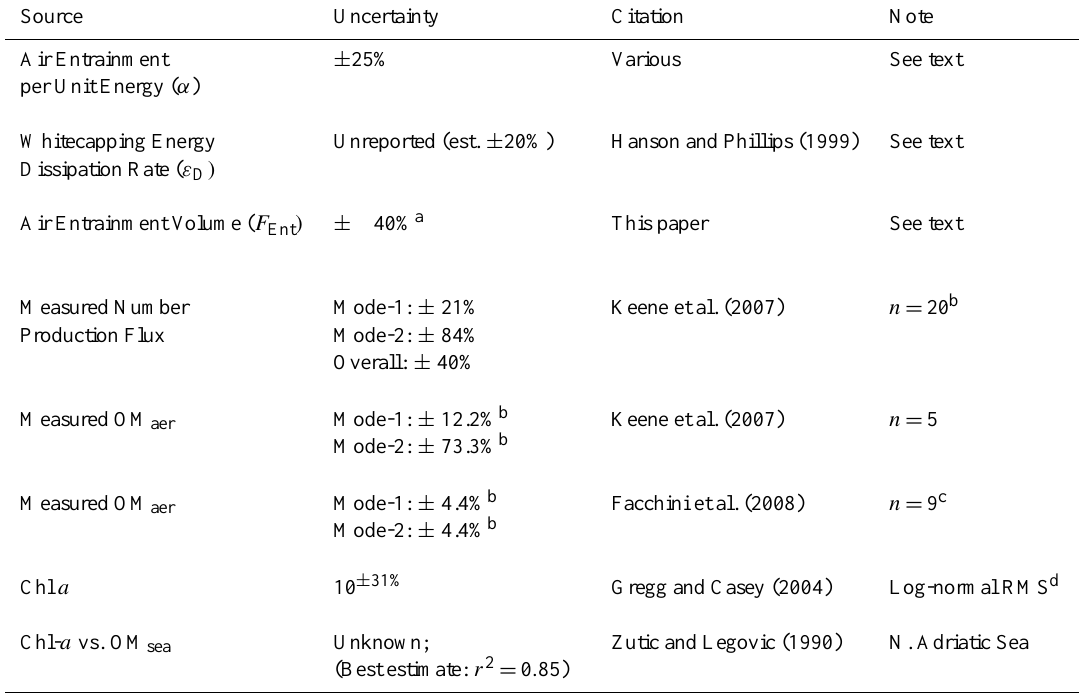
Table 4. Summary of major sources of uncertainty in parameterization. Source Uncertainty Citation Note ± 25% Various See text Air Entrainment per Unit Energy ( α ) Whitecapping Energy Unreported (est. ± 20%) Hanson and Phillips (1999) See text Dissipation Rate ( ε D ) Air Entrainment Volume ( F Ent ) ± 40% a This paper See text